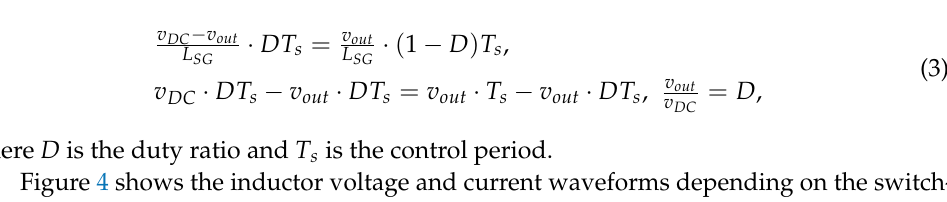
Figure 3. Equivalent operation circuit of buck converter which performs battery charging: ( a ) mode 1; ( b ) mode 2.